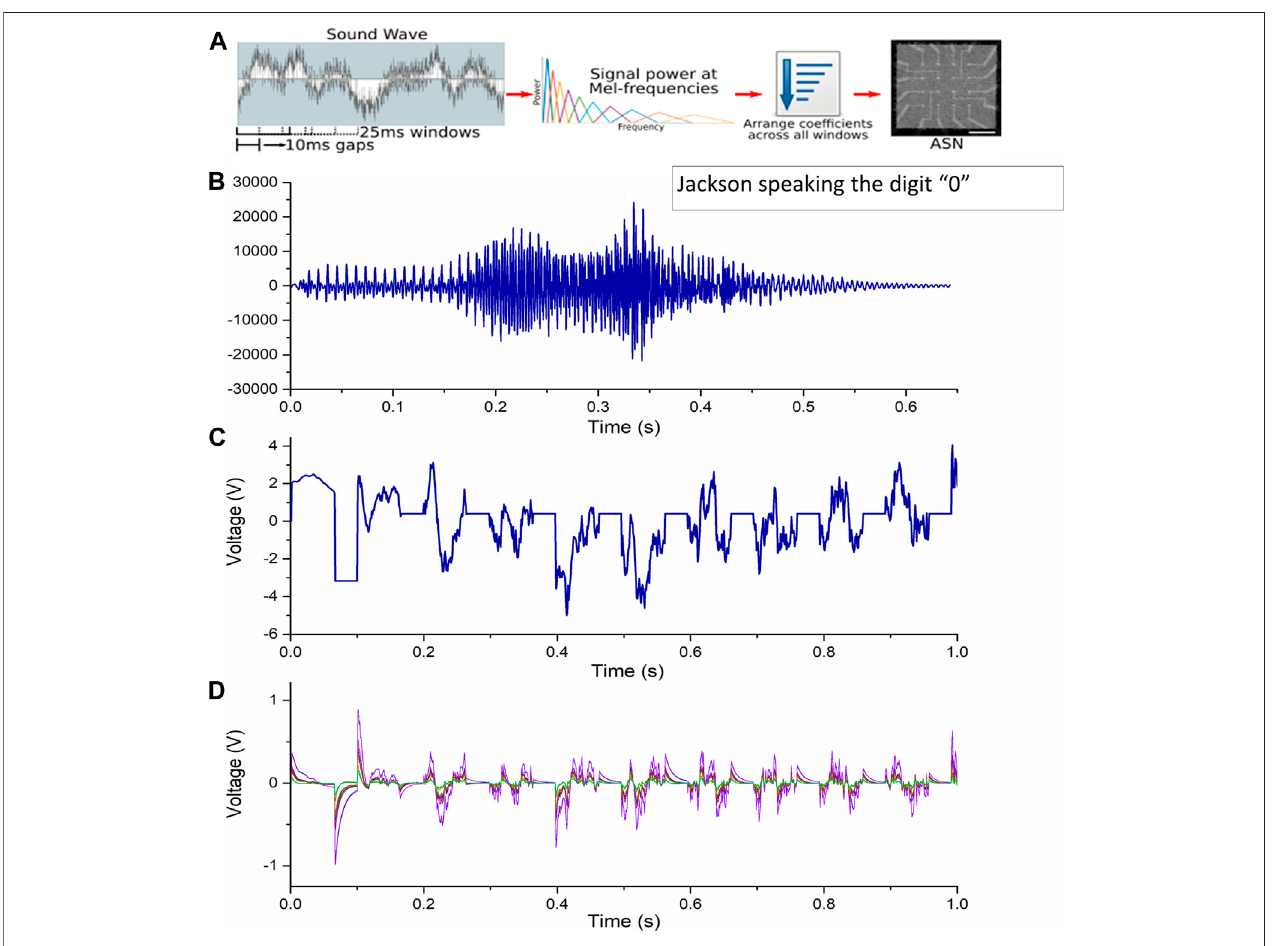
FIGURE 3 | (A) The work fl ow for RC-based speech recognition using ASN-based devices involved encoding and separation of raw audio data - spoken digits - data into overlapping windows, each of which was converted into 13 MFCCs. Individual MFCCs were arranged to minimize input thrashing and then delivered as input voltage to a single electrode of the ASN device. Output data, in the form of voltage traces, was collected at all remaining electrodes. (B) The raw FSDD audio signal of “ Jackson ” speakingthedigitzeroanditssubsequentconversiontoavoltagesignal (C) .Theresultant14voltagerecordingsandtheiruniqueresponsesareoverlaid in (D) with additional detail provided in Supplementary Material